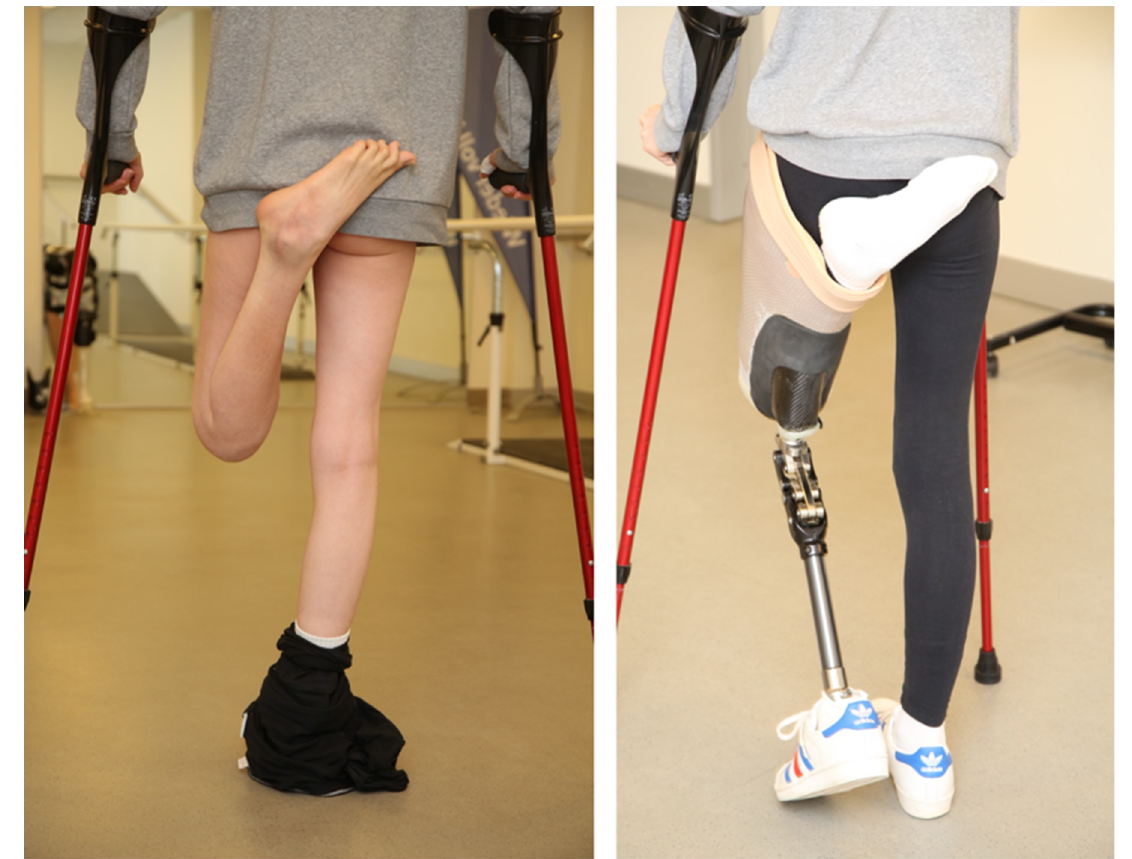
Figure 3. Algorithm demonstration on a 16 ‐ year ‐ old female patient with CRPS of the left knee. She developed flexion contracture. After hybrid fitting of the prosthesis, she was able to experience walking with her prospective future prosthetic device.